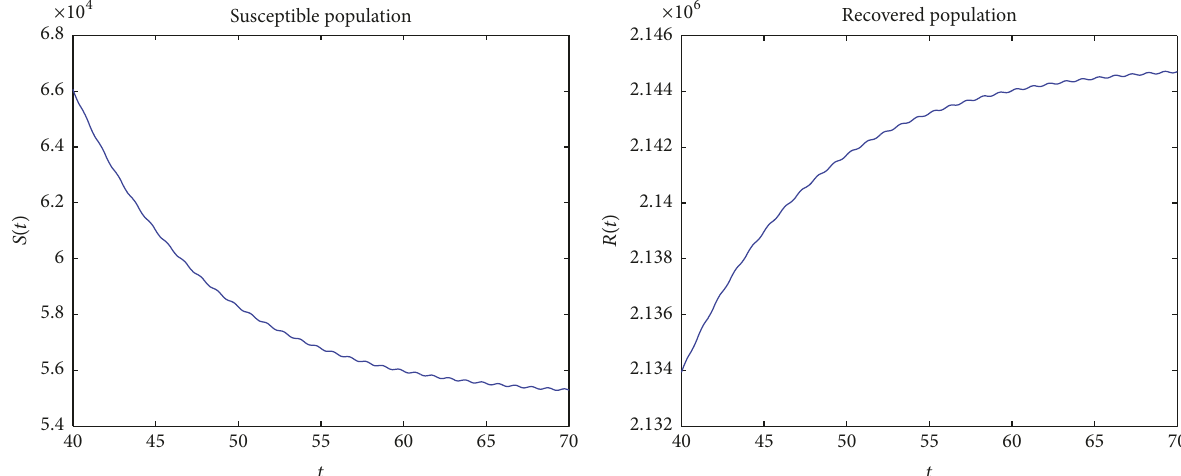
̂𝑆(𝑡) (see Figure 1),